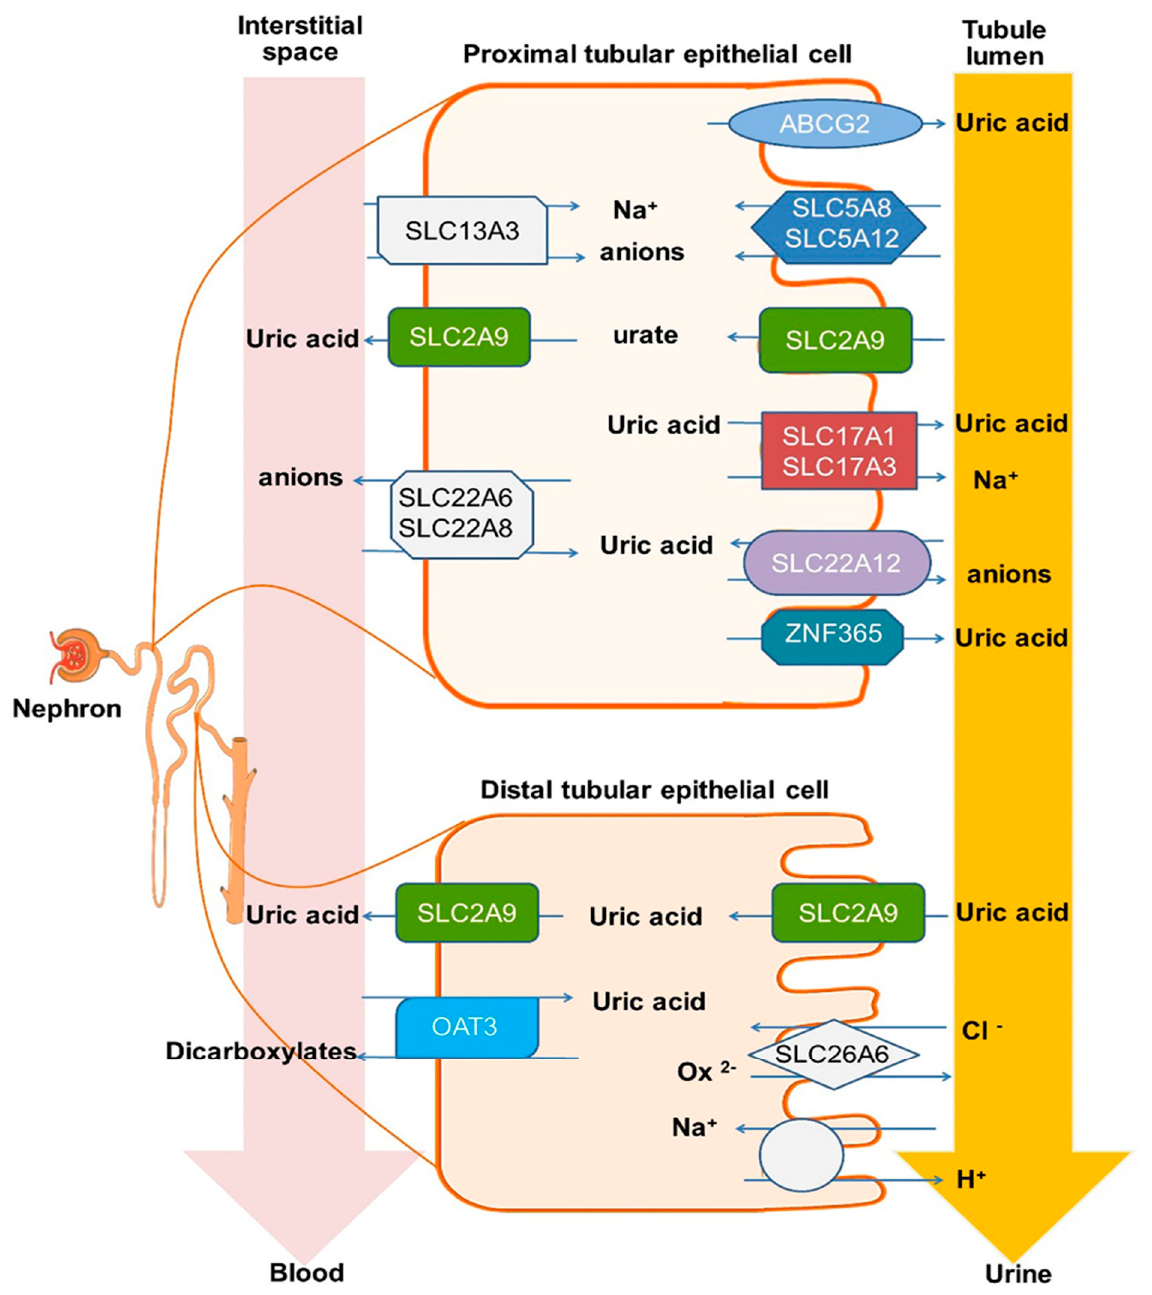
Figure 1. Diagrammatic presentation of the renal expression of six renal tubular uric acid (UA) transporters and their functions in the proximal and distal nephron. SLC2A9 (solute carrier family 2, glucose transporter member 9) is expressed in both the apical and basolateral membrane of proximal and distal tubular cells, and functions as a urate uniporter/urate reabsorption. SLC17A3 (solute carrier family 17 (organic anion transporter), member 3) is expressed on the apical membrane of